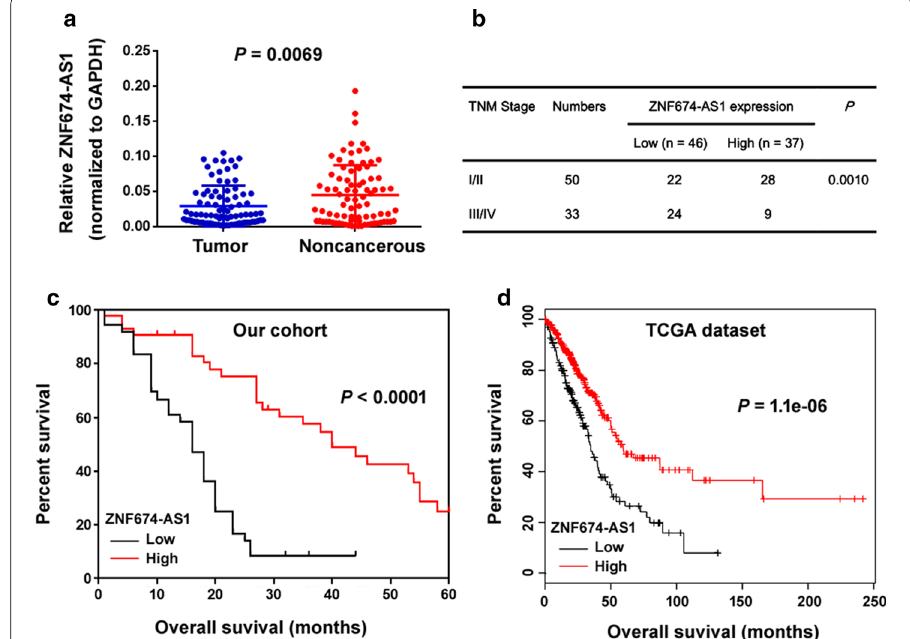
Fig. 1 ZNF674-AS1 is downregulated and predicts poor prognosis in NSCLC. a Analysis of ZNF674-AS1 levels in 83 pairs of NSCLC specimens and adjacent noncancerous lung tissues. b Downregulation of ZNF674-AS1 was significantly associated with advanced TNM stage of NSCLC. c Kaplan–Meier analysis showed that reduced ZNF674-AS1 expression was associated with shorter overall survival of NSCLC patients. d Based on the lung adenocarcinoma TCGA dataset included in KM Plotter, ZNF674-AS1 expression was associated with decreased overall